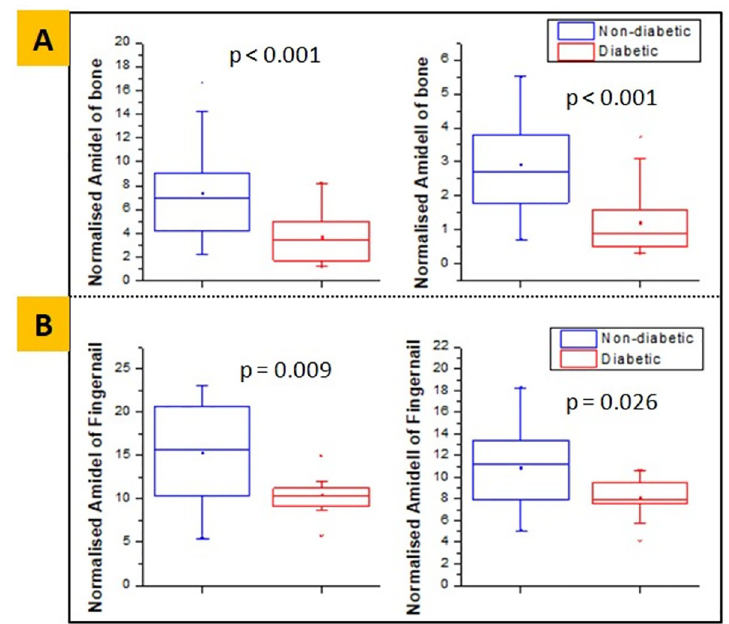
Fig 4. Normalized Amide I and Amide II area obtained from FTIR, showing lower mean values in diabetic group for both bone (A) and fingernail (B) respectively.